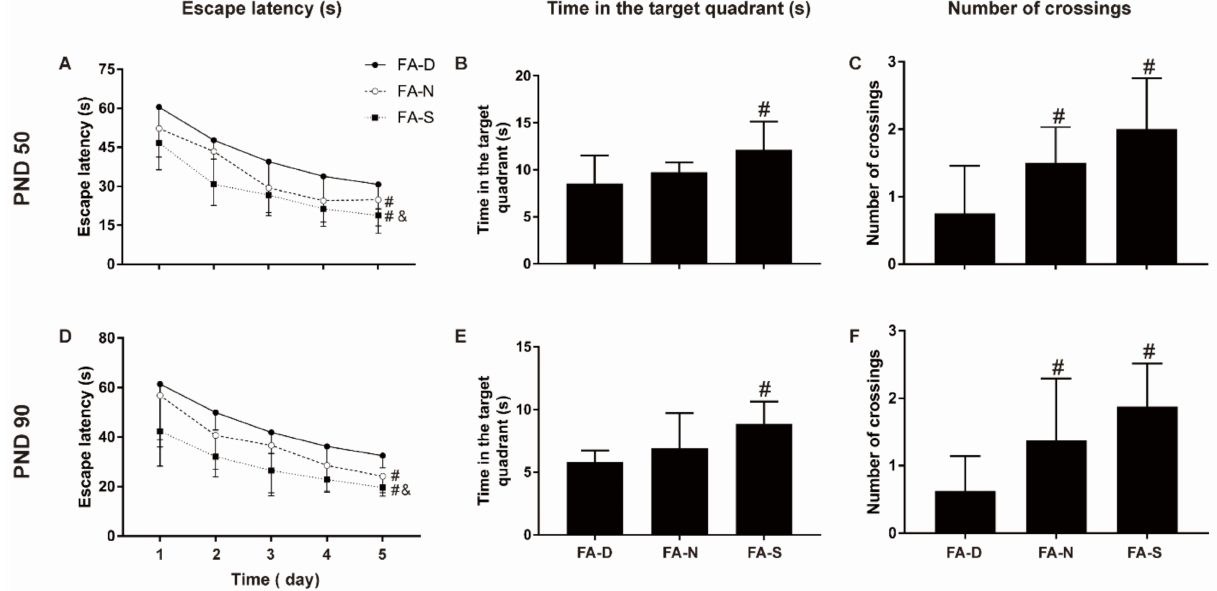
Figure 3. Folic acid improved spatial learning and memory ability in adolescent and adult offspring. Dams and pups were fed as described in Figure 1. ( A ) Escape latency during the spatial